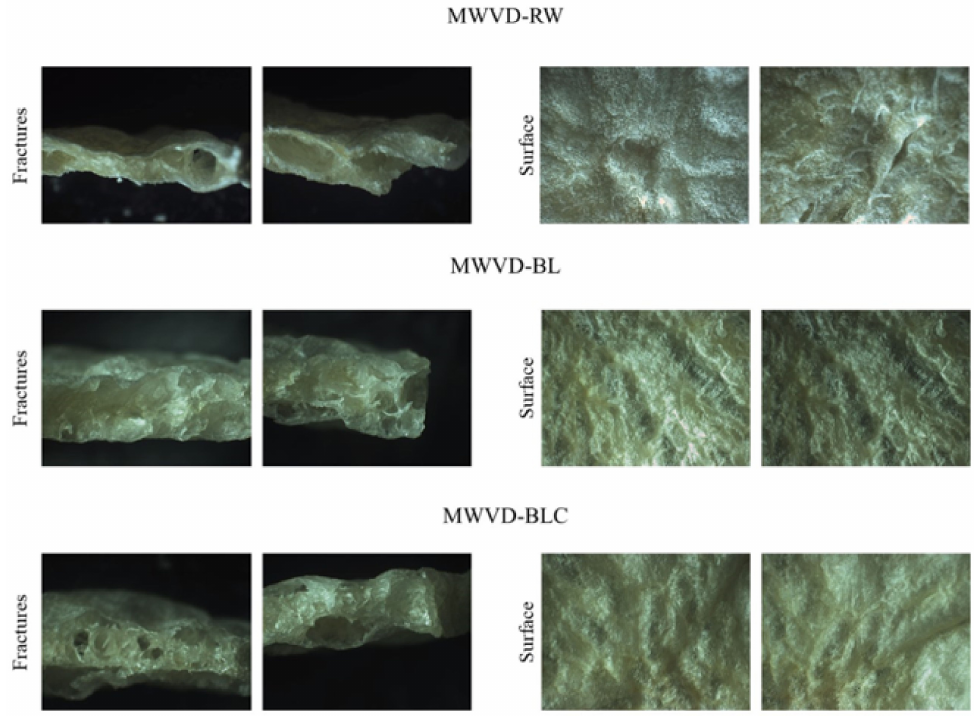
Figure 5. Optical micrographs of fractures and surface of dried samples MWVD-RW, MWVD-BL, and